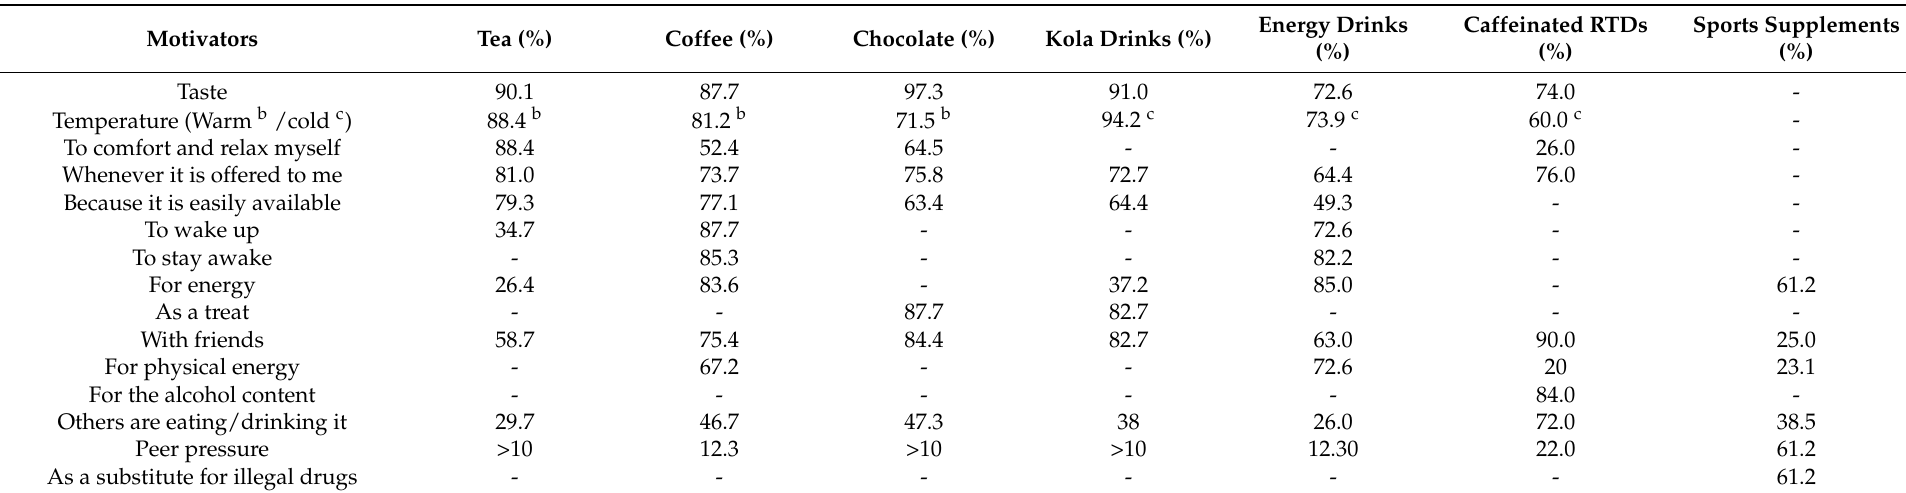
Table 4. Percentage agreement of motivation for caffeinated product consumption a